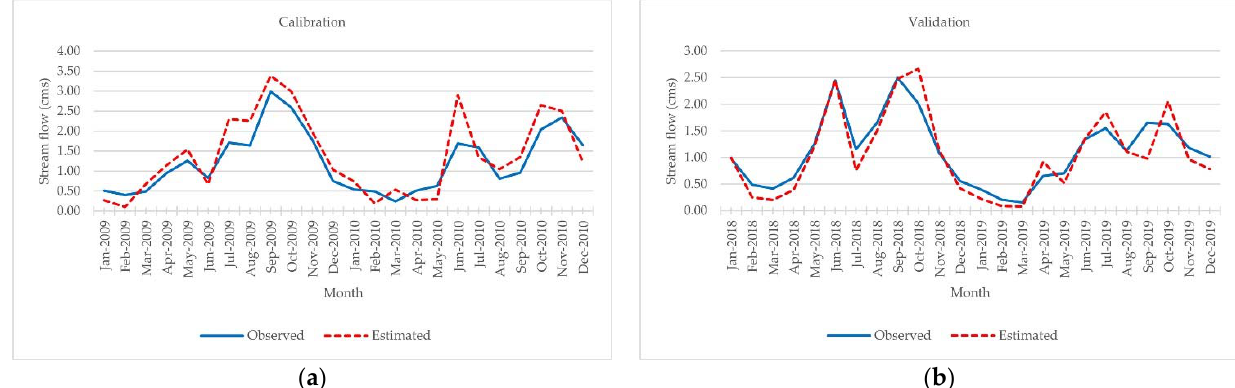
Figure 8. Monthly observed and estimated streamflow at Khlong Bang Yai watershed under the dry year condition: ( a ) calibration period; ( b ) validation period.